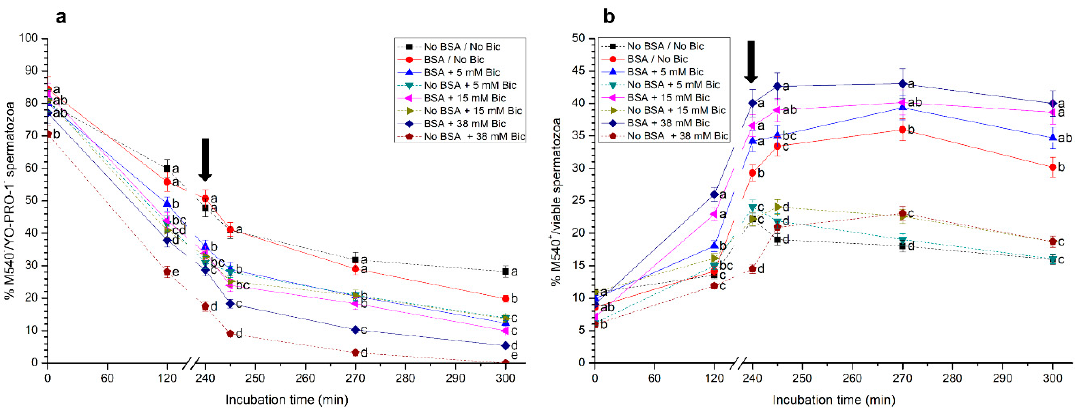
Figure 2. ( a ) Percentages of viable sperm with low membrane lipid disorder (M540 − /YO-PRO-1 − ), and ( b ) percentages of sperm with high membrane lipid disorder considering the viable sperm population only (M540 + /viable sperm) following incubation with different concentrations of bicarbonate (Bic; 0 mM, 5 mM, 15 mM, 38 mM) and BSA (0, 5 mg/mL) for 300 min. The black arrow indicates the time at which 10 µ g/mL of progesterone was added (i.e., 240 min) to induce acrosome exocytosis. Different superscripts (a–e) indicate significant differences ( p < 0.05) between treatments within the same time point. Data are shown as mean ± SEM for 12 independent experiments.